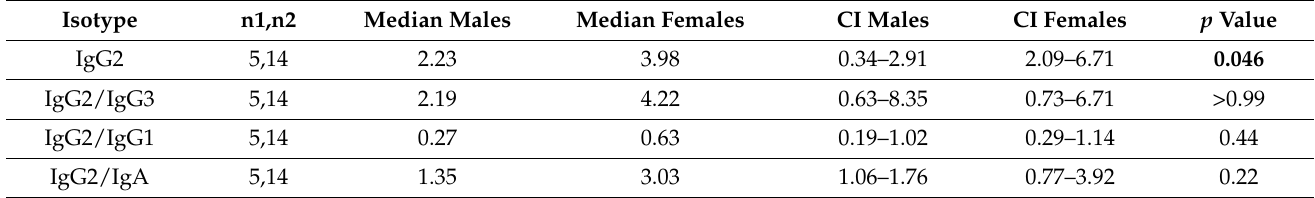
Figure 5. Isotype profiles in males and females in the influenza virus study. Each symbol represents a different participant. Group medians are shown with 95% CI. p values from Mann–Whitney tests are shown when p ≤ 0.10. Individual isotypes ( A – E ) and ratios ( F – H ) are shown. Table 5. Higher IgG2 in females compared to males in a human influenza study.